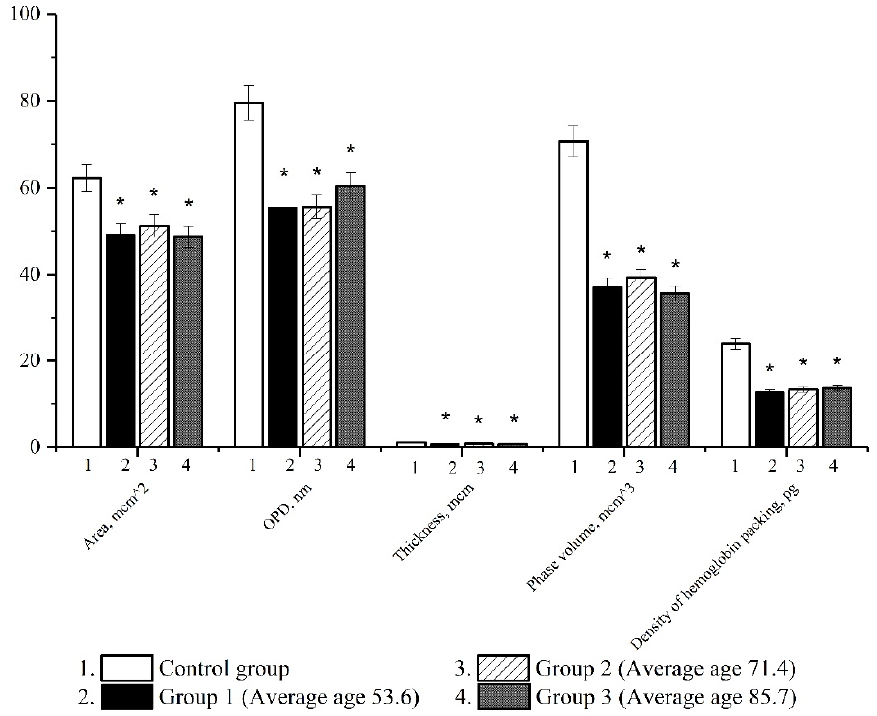
Figure 3. Study of the erythrocyte morphology of the control group and different age groups during the development of COVID-19 (* p ≤ 0.05 is the change in relation to the control). LIM allowed us to obtain 3D models of the erythrocyte phase image of the control group, as well as the other groups. The data are shown in Figure 4. With the development of the disease, there is a redistribution of intracellular con- tents, namely, hemoglobin, and the data in Figure 3 also prove this (Hb packing density), which in turn leads to the disorder of erythrocytes’ oxygen transport functions. The 3D model of the phase image of erythrocytes in patients diagnosed with a novel coronavirus infection has irregularities and surface roughness. Based on the data we obtained, the uni- form distribution of hemoglobin and cytoplasm in erythrocytes was observed to be dis- turbed in pathology (Figure 3). The formation of local cytoplasmic clusters with an in- creased hemoglobin content was found. The revealed changes in the distribution of he- moglobin may cause the development of hypoxia due to the uneven redistribution of ox- ygen and carbon dioxide molecules during the hemodynamics of cells in blood vessels.